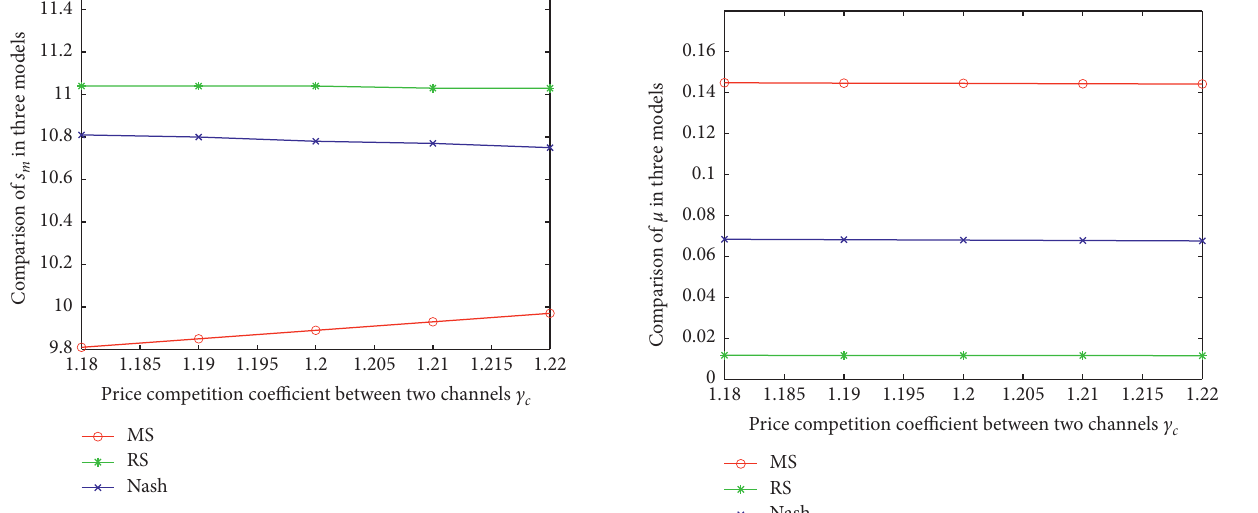
Figure 10: The comparison of the optimal service level of standard products in the direct sales channel s m in the three models.